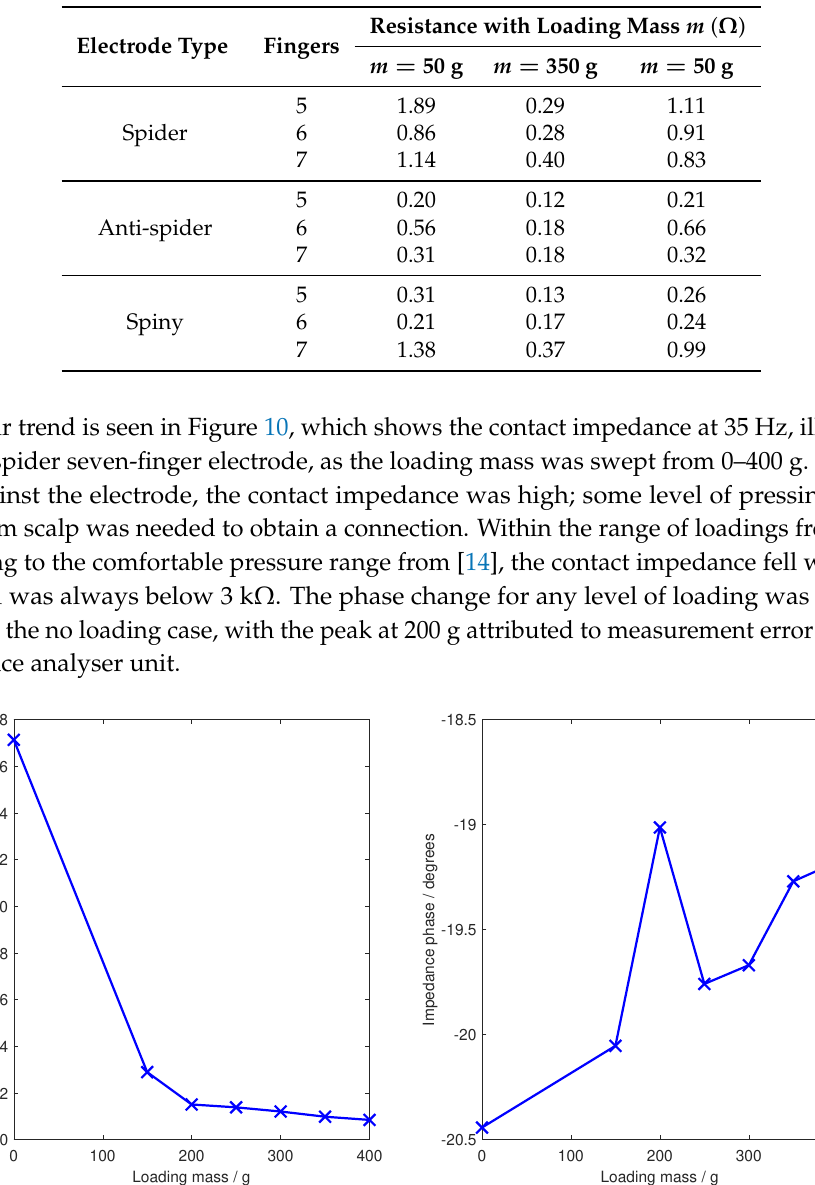
Table 3. Bulk resistance of electrodes when loading is varied from 50–350 g and back to 50 g.